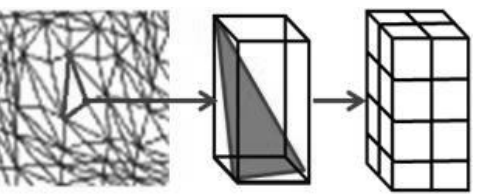
Figure 4. The AABB Collision detection method. Each small black cube is the unit of sampling (cube space).